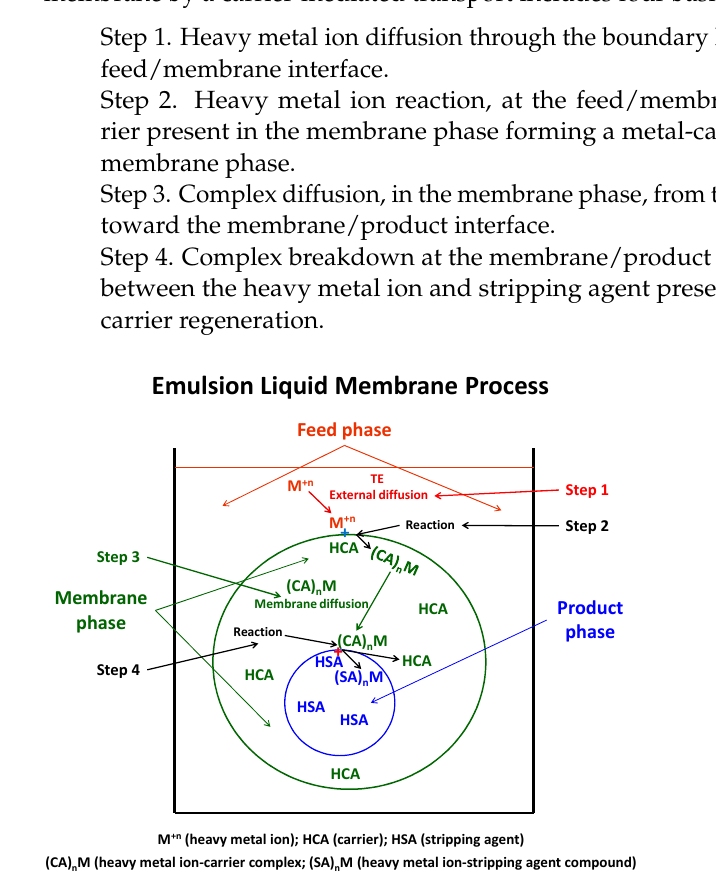
Figure 1. Mechanism of heavy metal ion permeation through an emulsion liquid membrane by carrier-mediated transport.